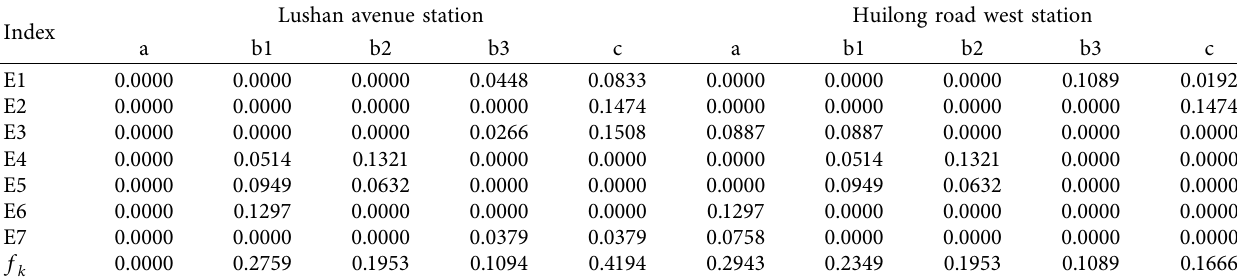
Table 8: The combination of the weights and the five environmental risk levels of the indicators.